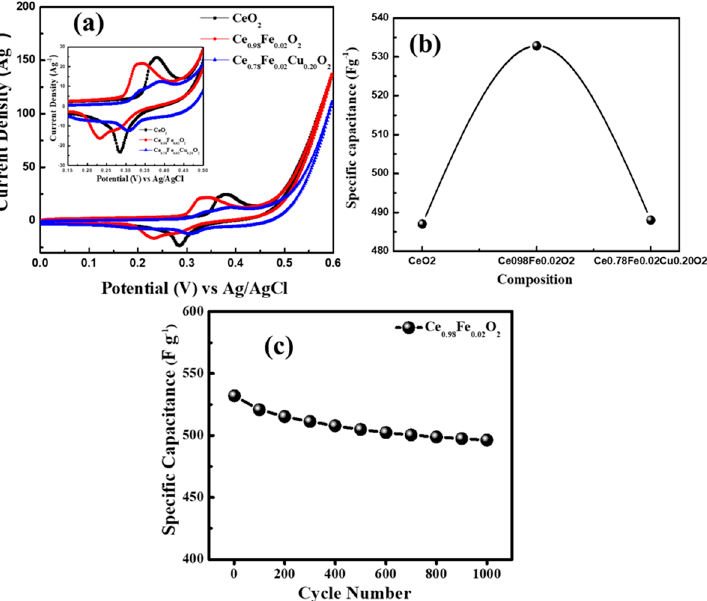
Figure 6. ( a – c ) CV plots of CeO 2 , Ce 0.98 Fe 0.02 O 2 , and Ce 0.78 Fe 0.02 Cu 0.20 O 2 nanoparticles with different scan rates. ( d – f ) Variation in specific capacitance of CeO 2 , Ce 0.98 Fe 0.02 O 2 , and Ce 0.78 Fe 0.02 Cu 0.20 O 2 na- noparticle electrodes with different scan rates.